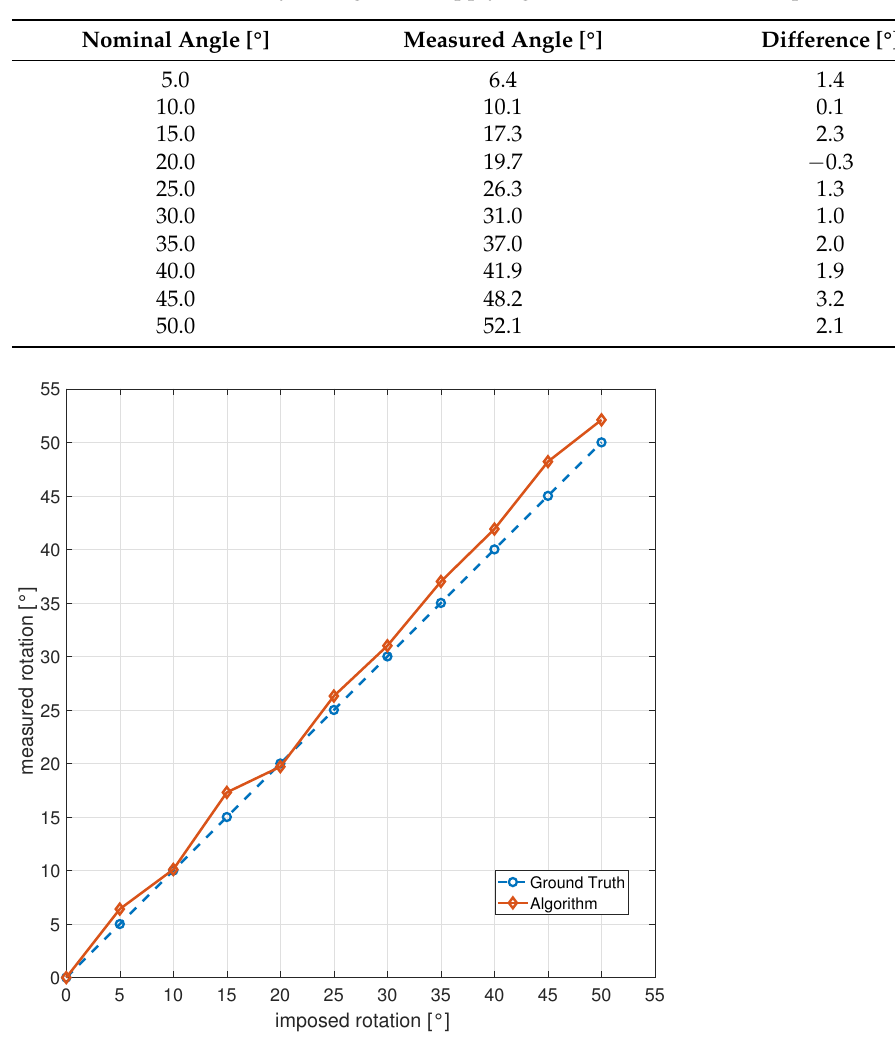
Figure 9. Scheme of the rotations and translations imposed to the camera. Table 1. Results obtained by the algorithm, applying a rotation of 5° at each step.